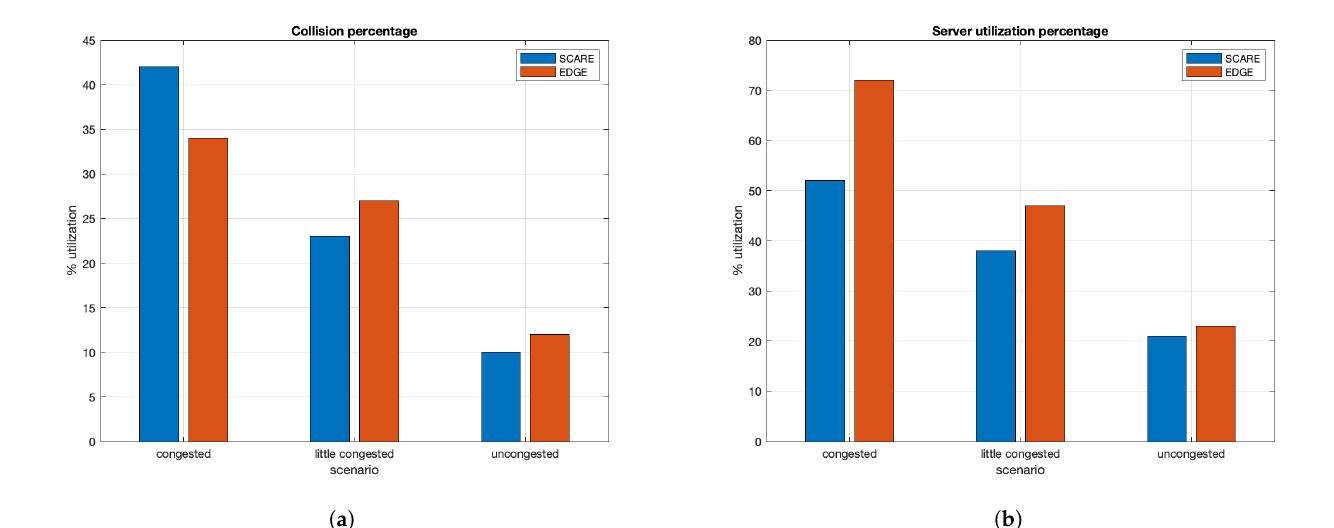
Figure 10. ( a ) Collision percentage vs. vehicles distance; ( b ) server utilization vs. traffic congestion.